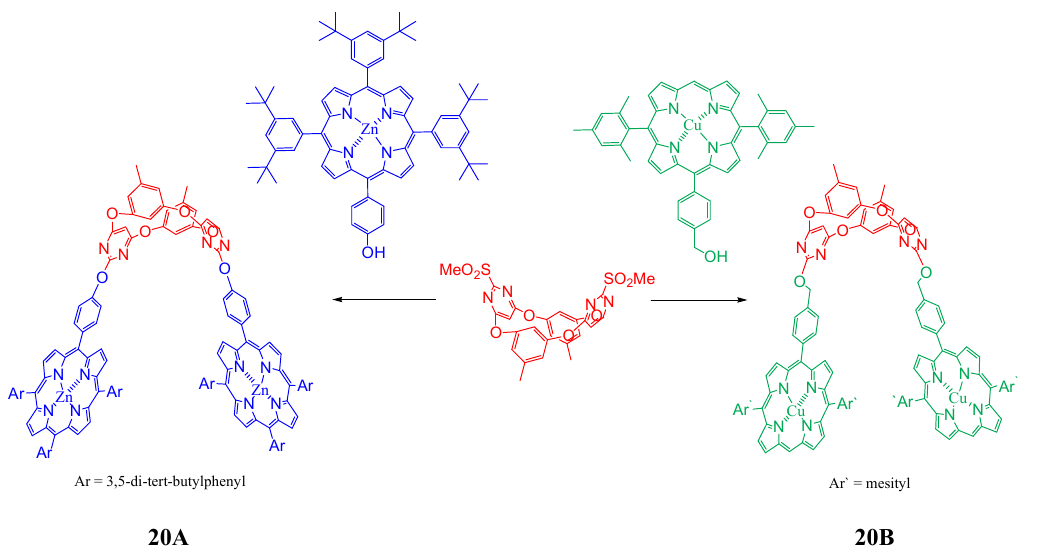
Figure 21. Oxaclixarene tweezers based on porphyrin ( 20A ) and corrole ( 20B